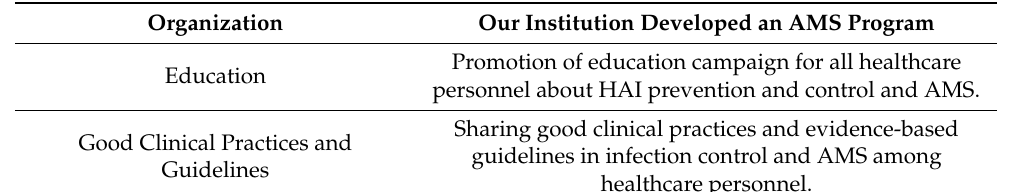
Table 1. A summary of the antimicrobial stewardship program’s key points (HAIs: hospital-acquired infections; AMS: antimicrobial stewardship; CAIs: community-acquired infections).